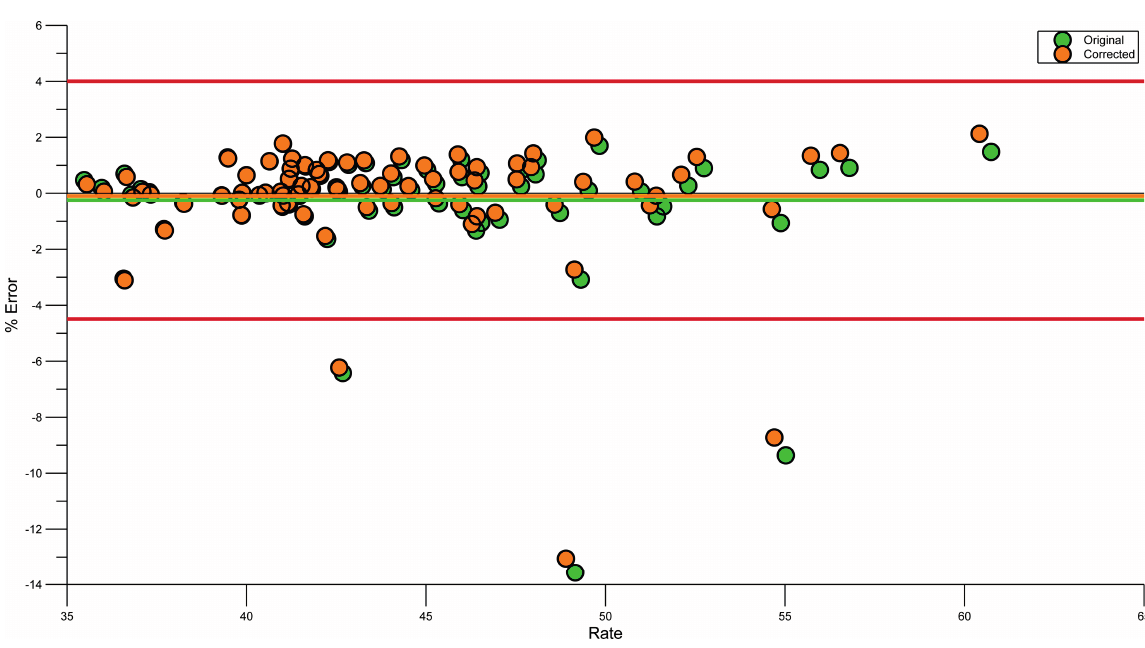
Figure 10. Bland Altman plot showing error in stroke rate after Regression correction. Green before correction, Orange after